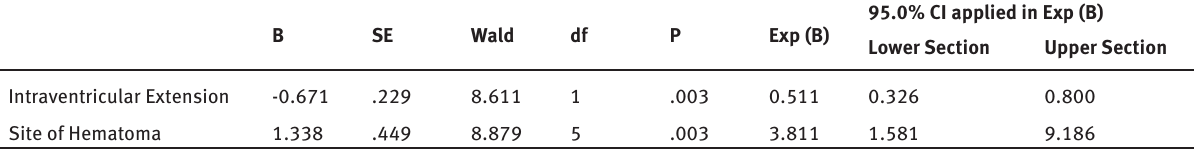
Table 2: Multivariate analysis of factors influencing survival in 196 young adult patients with ICH